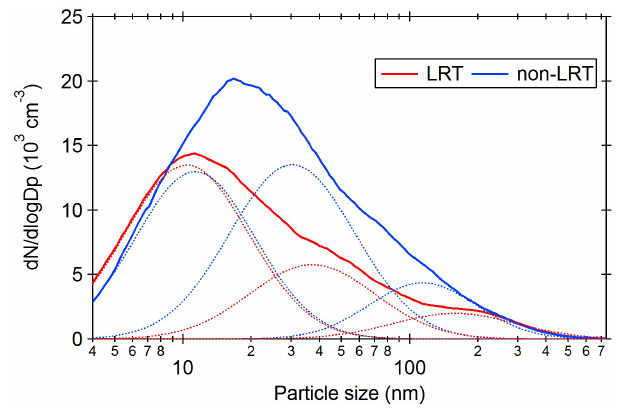
Figure 10. Averaged PSDs for LRT and non-LRT episodes mea- sured during the seasons of winter monsoons. Dashed lines illustrate the PSD of each individual